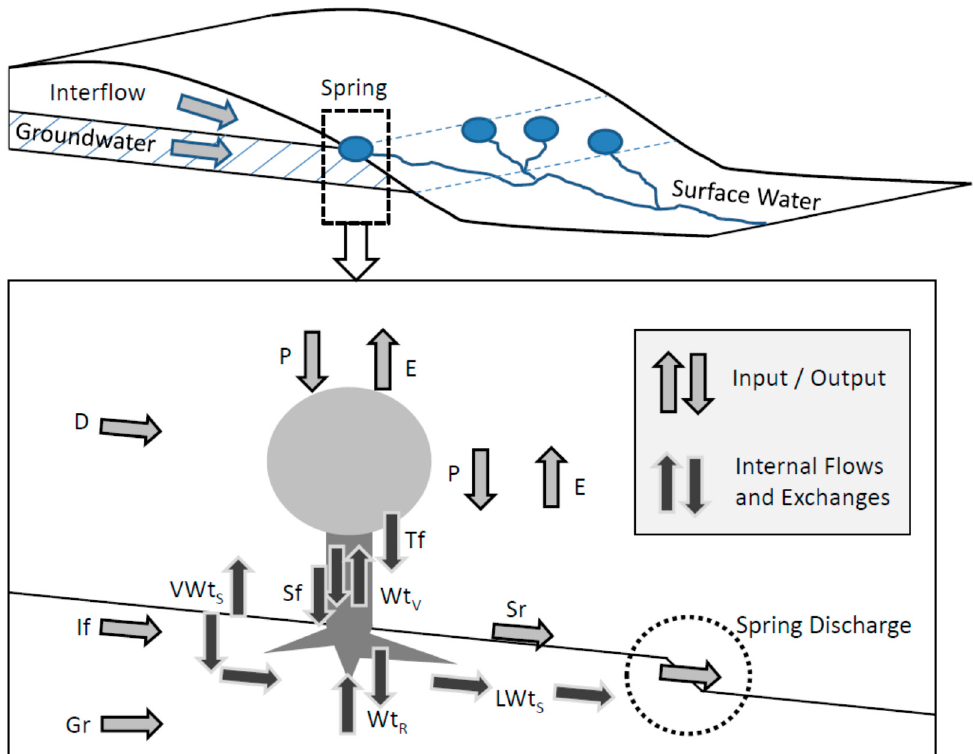
Figure 2. Schematic illustration of substance flows in a headwater region above a spring outlet. In- and Outputs are controlled within the water cycle. Internal flows should represent matter fluxes within the corresponding cycles, mostly at different interfaces (e.g., the soil–atmosphere or root/vegetation–soil interfaces). P: precipitation; E: evaporation (evapotranspiration); D: Deposition; Sr: Surface runoff; If: Interflow; Gr: Groundwater runoff; Tf: Through flow; Sf: Steam flow; Wt V : Water exchange (vegetation); Wt R : Water exchange (root–soil); VWt S : Vertical water exchange (soil–atmosphere); LWt S : Lateral water exchange (soil). Inspired by [46].